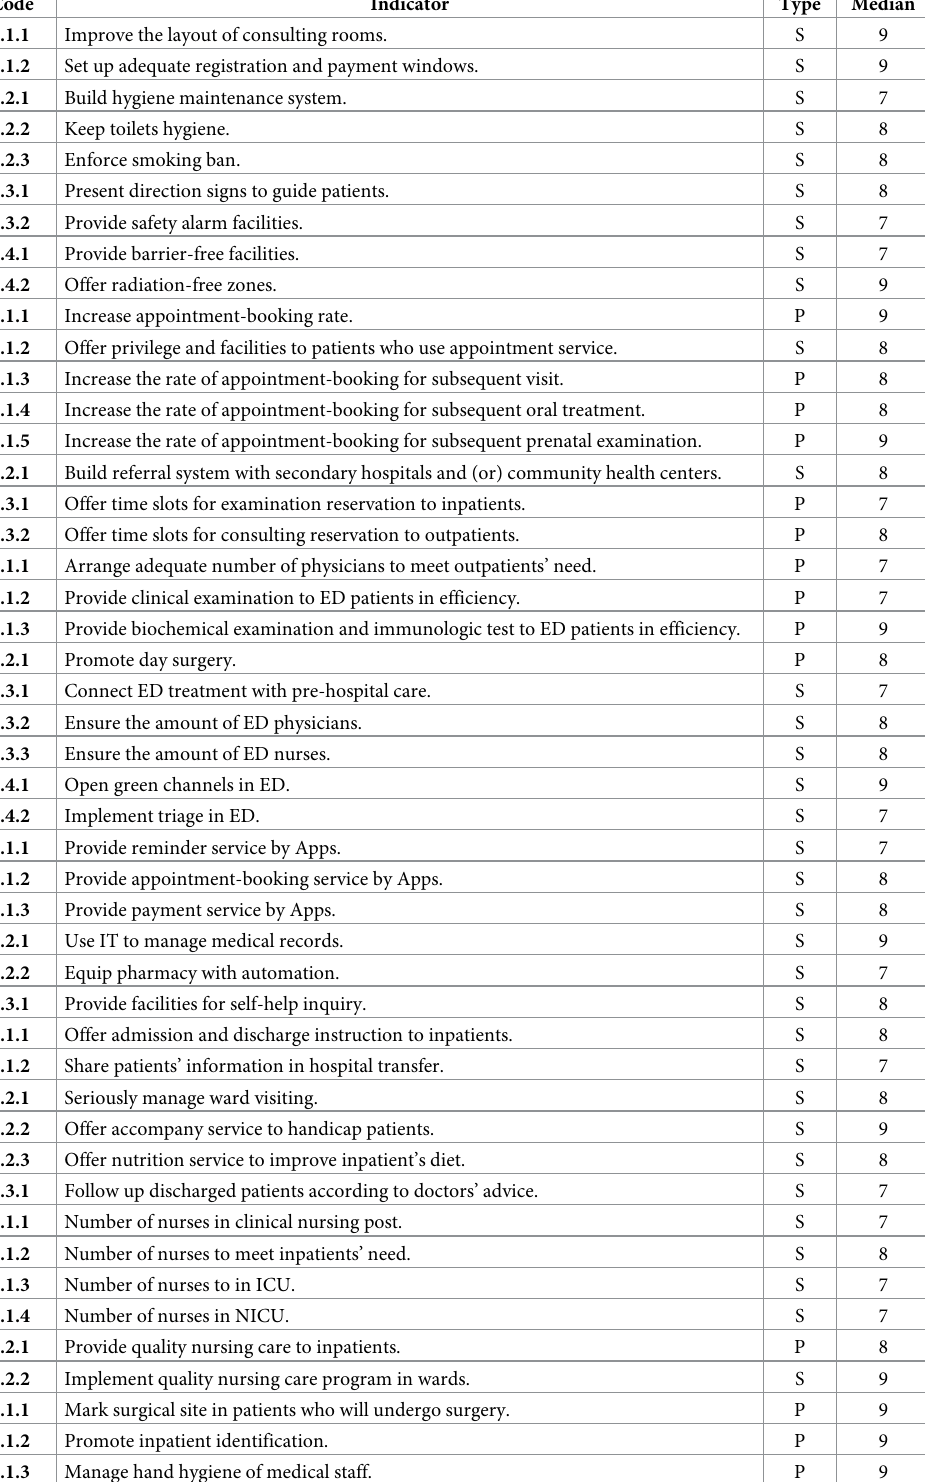
Table 2. Results of second round